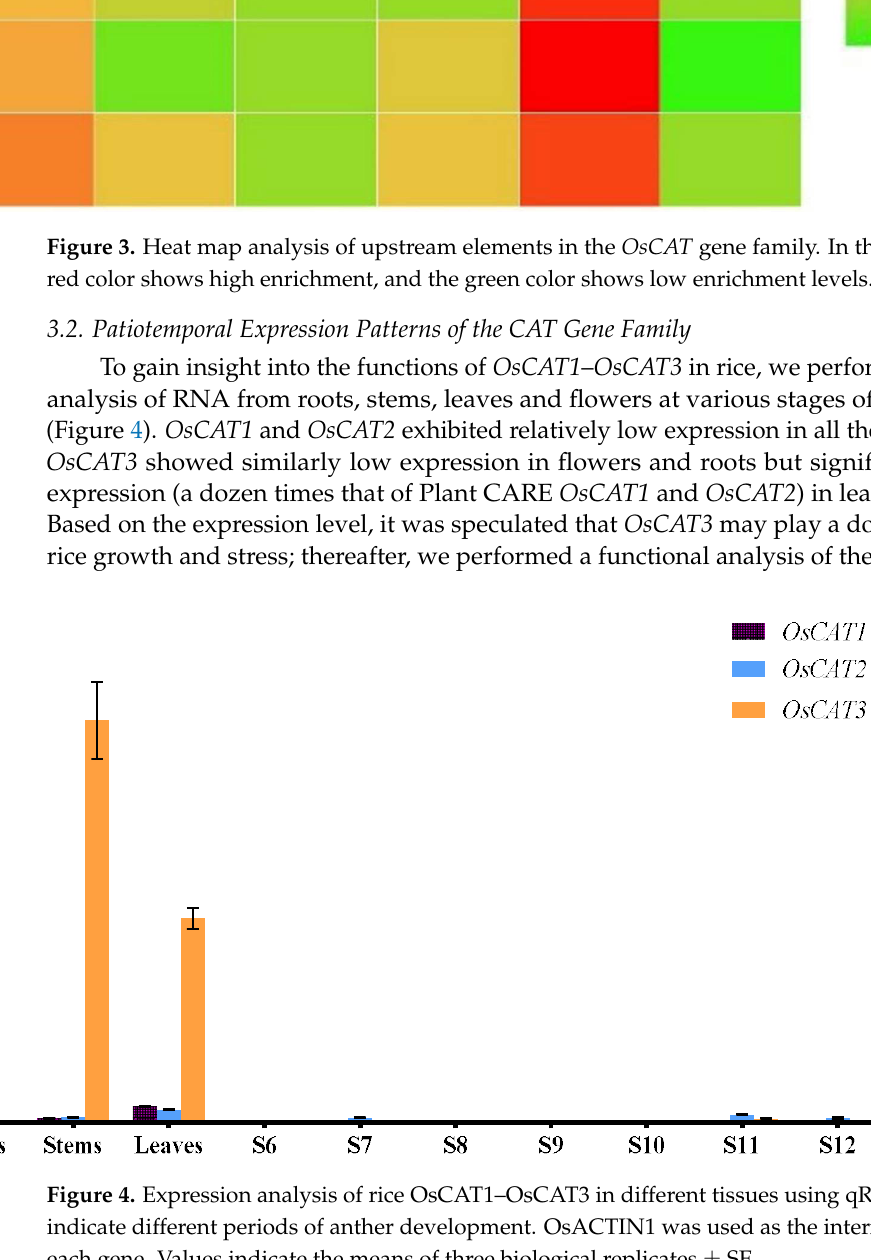
Figure 2. Phylogenetic relationship and architecture of 24 CAT proteins. According to the phyloge- netic relationships, the CAT genes from seven species were clustered into three groups (Clade I−III).